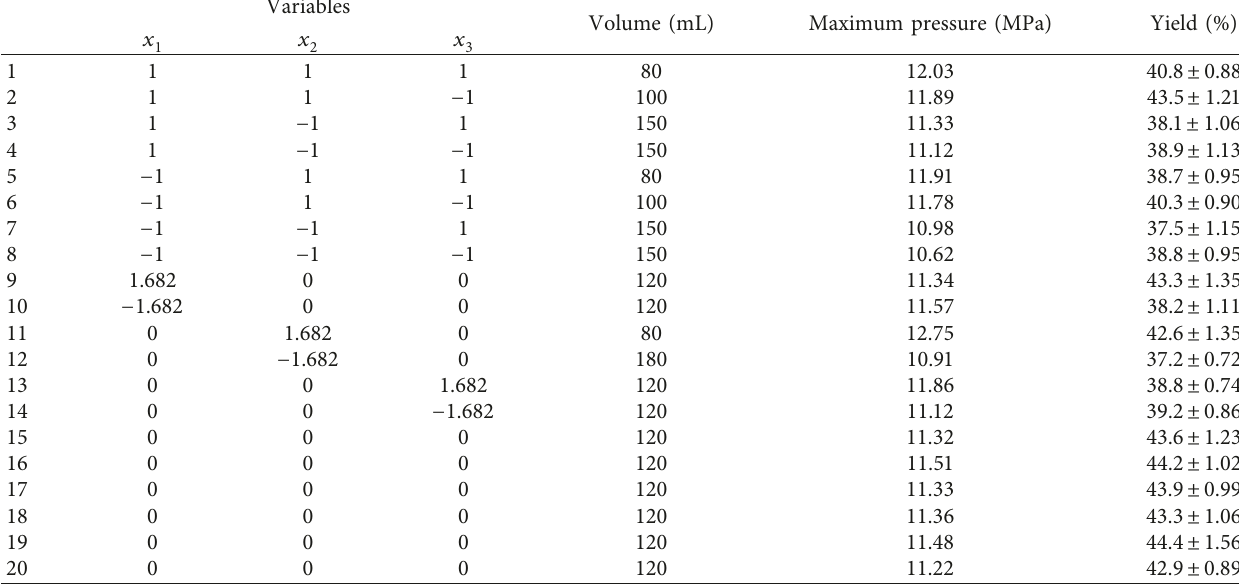
Table 3: Experimental design and the results.